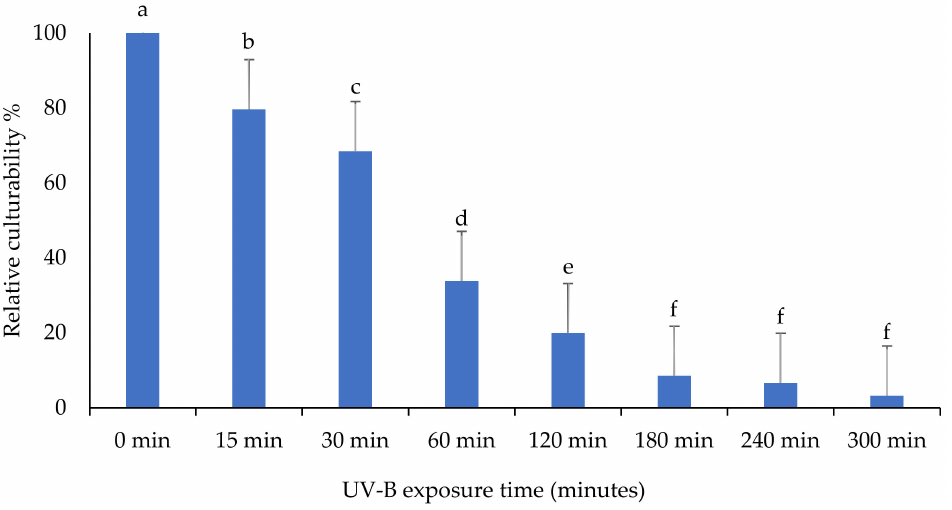
Figure 3. The impact of different UV-B exposure times on relative culturability percentage of Beauveria bassiana isolate “BbSA-2”. The mean number of relative culturability percentage ± SE is shown. Different letters on the same patterned bars indicate significant differences (LSD test, p <